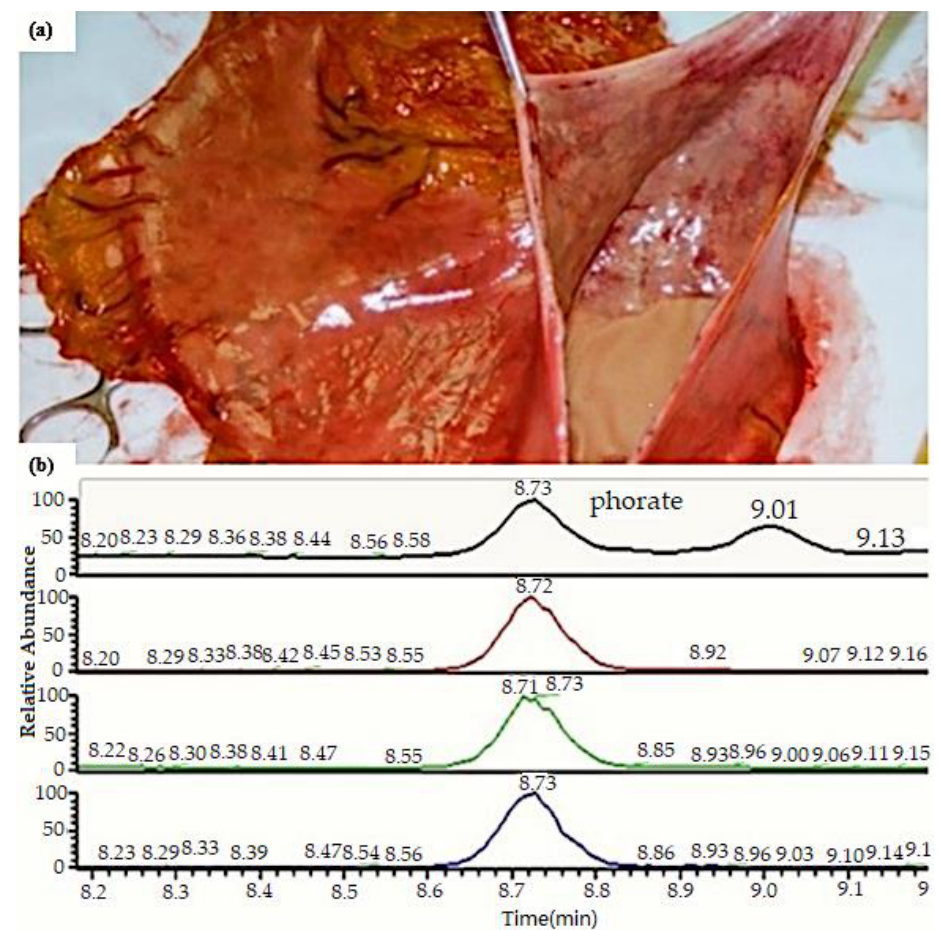
Figure 1. ( a ) the stomach’s opening: stomach contained 100 mL of brown color; ( b ) chromatogram of the case.